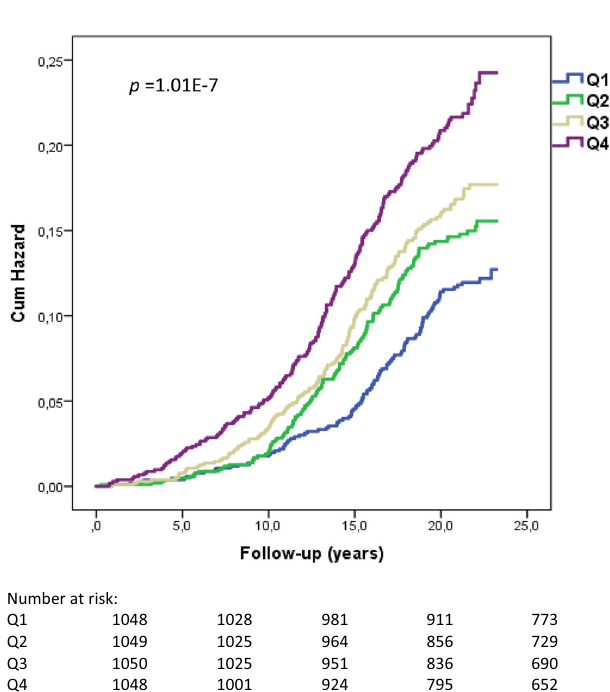
Fig. 1 Kaplan – Meier curve to illustrate incidence of diabetes in relation to follistatin quartiles. Time axis was follow-up time until death, emigration, incident diabetes or end of follow-up ( n = 4195; p = 1.01E-7; two-sided